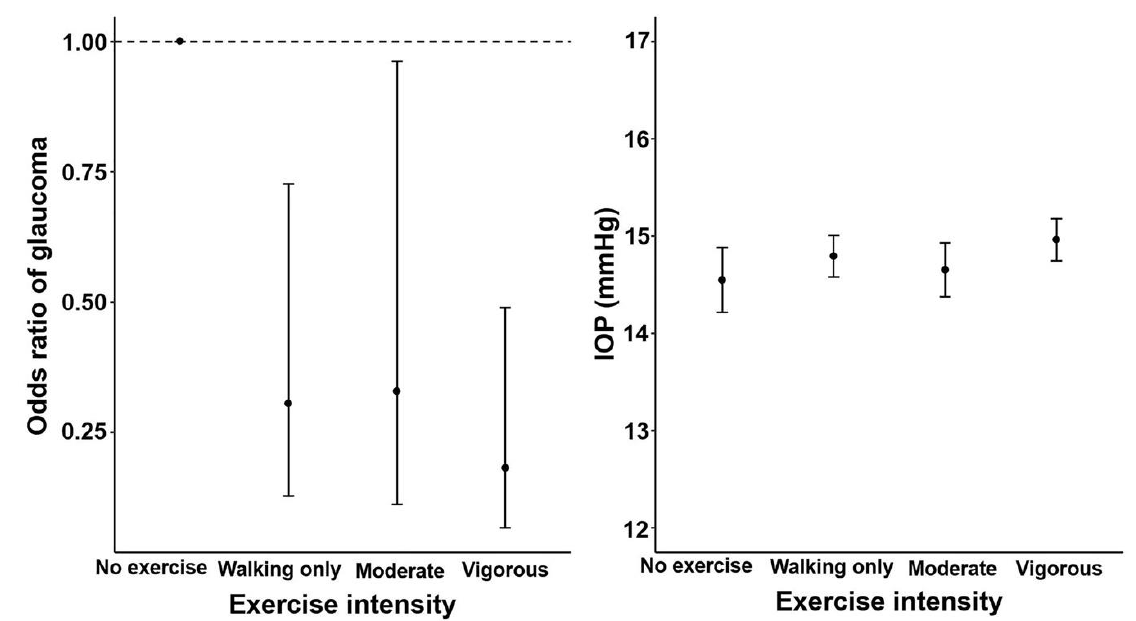
Figure 2. Odds ratios for glaucoma and mean IOP according to the intensity of exercise in men aged ≥ 40 years. Trend p using a logistic and linear regression model after adjusting for age, body mass index, smoking, drinking, monthly income, total energy intake, caffeine intake, hypertension diabetes mellitus, spherical equivalents. For odds of glaucoma, model 5 was used and for IOP, model 4 was used. Error bars indicate 95% confidence intervals. IOP, intraocular pressure. Table 2. Regression analysis for glaucoma and IOPmax according to intensity of physical activity.